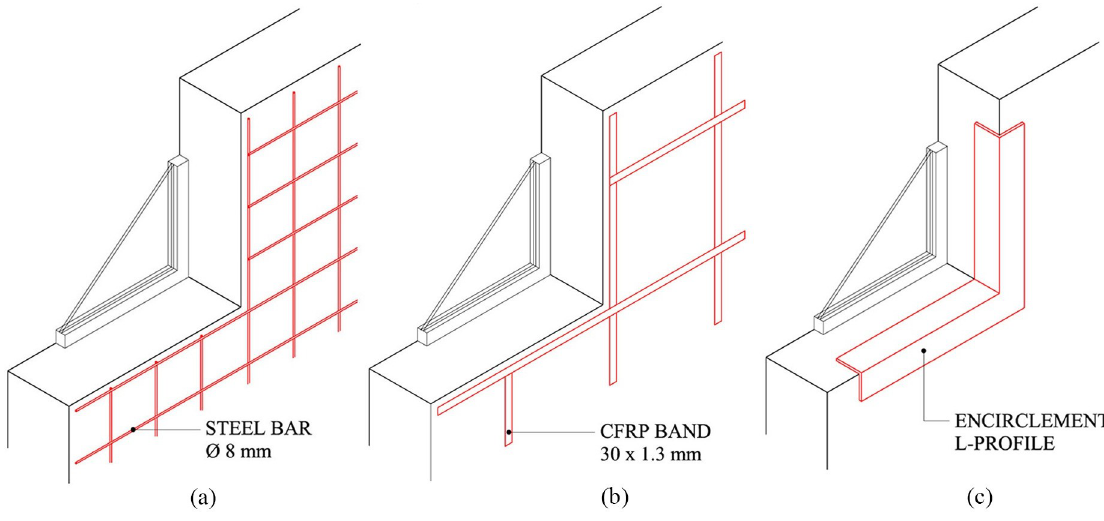
Fig 4. Retrofitting techniques: steel grid (a), CFRP grid (b) and encirclements (c).